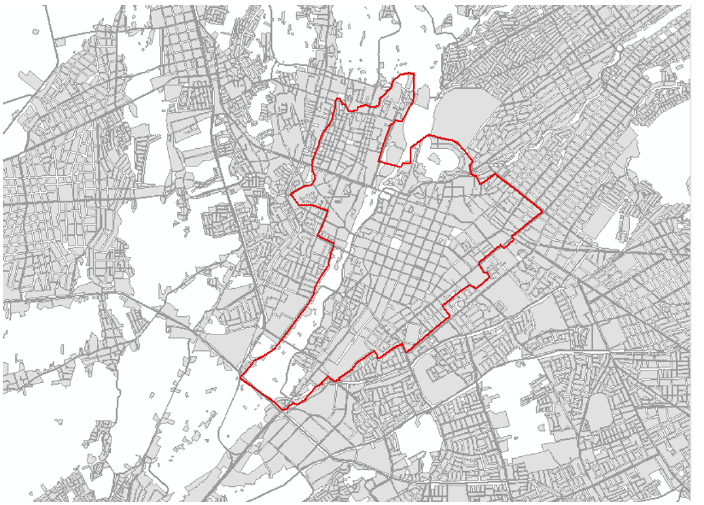
Figure 1. Map of the historical center of the city of Arequipa (own elaboration from data based on PlaMCha,